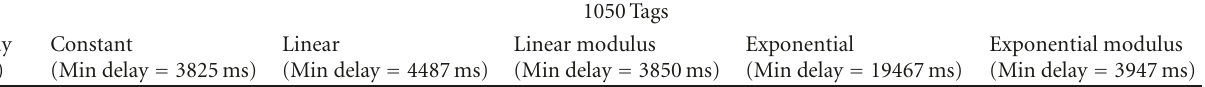
Table 5: The ICW and the coe ffi cient values, C , L , and E , giving lowest energy consumption (Energy) when choosing a specific delay, 1050tags, and the di ff erent algorithms.